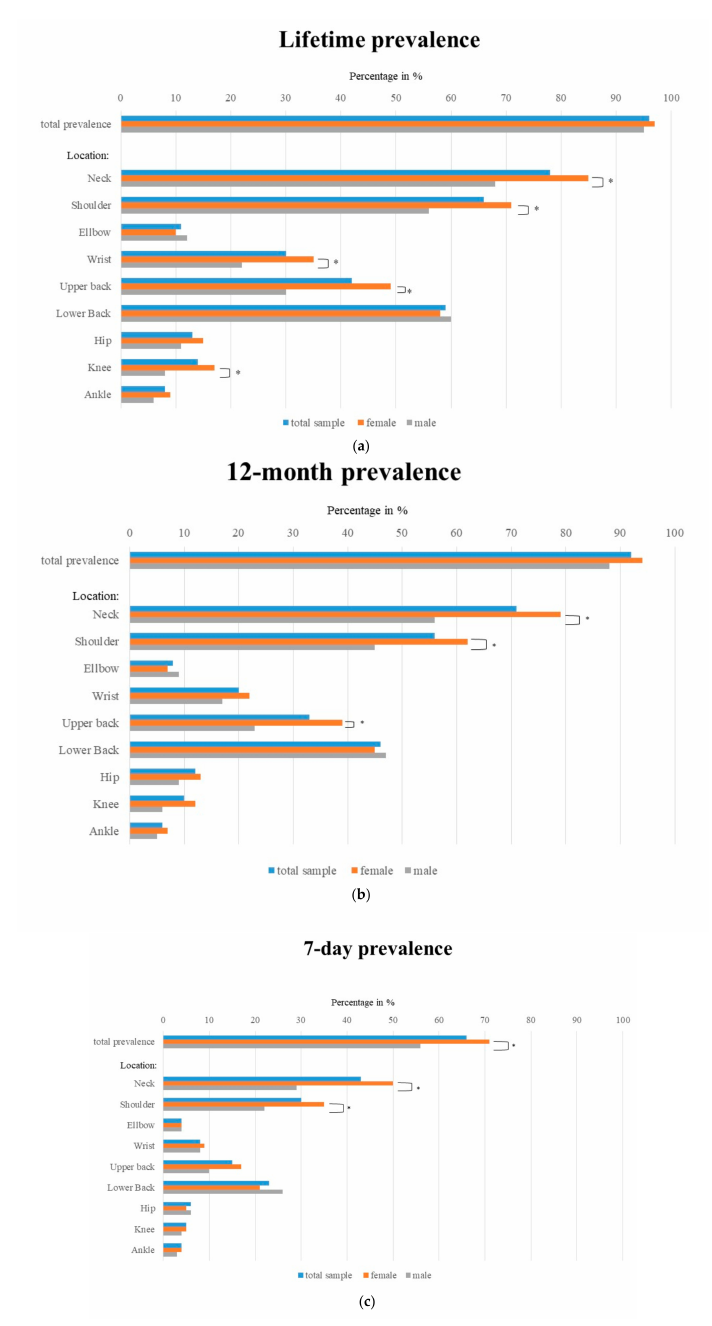
Figure 2. ( a ) Distribution of musculoskeletal disorder (MSD) among all participants ( n = 450), female participants ( n = 287) and male participants over lifetime. ( b ) Distribution of MSD among all participants ( n = 450), female participants ( n = 287) and male participants for 12-month prevalence. ( c ) Distribution of MSD among all participants ( n = 450), female participants ( n = 287) and male participants for 7-day prevalence. * means p <